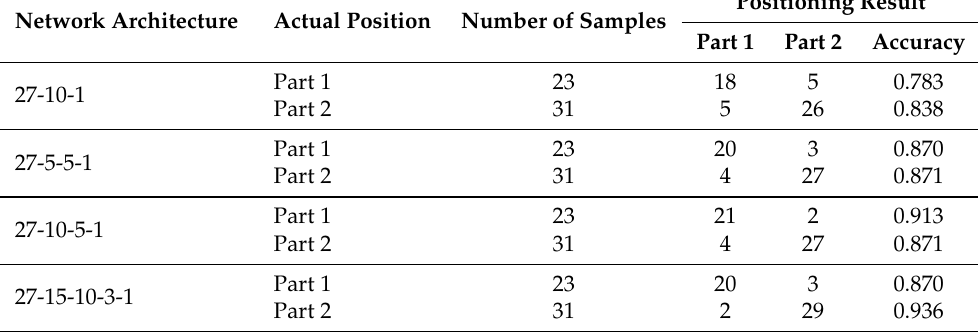
Table 6. Accuracy of collision positioning.